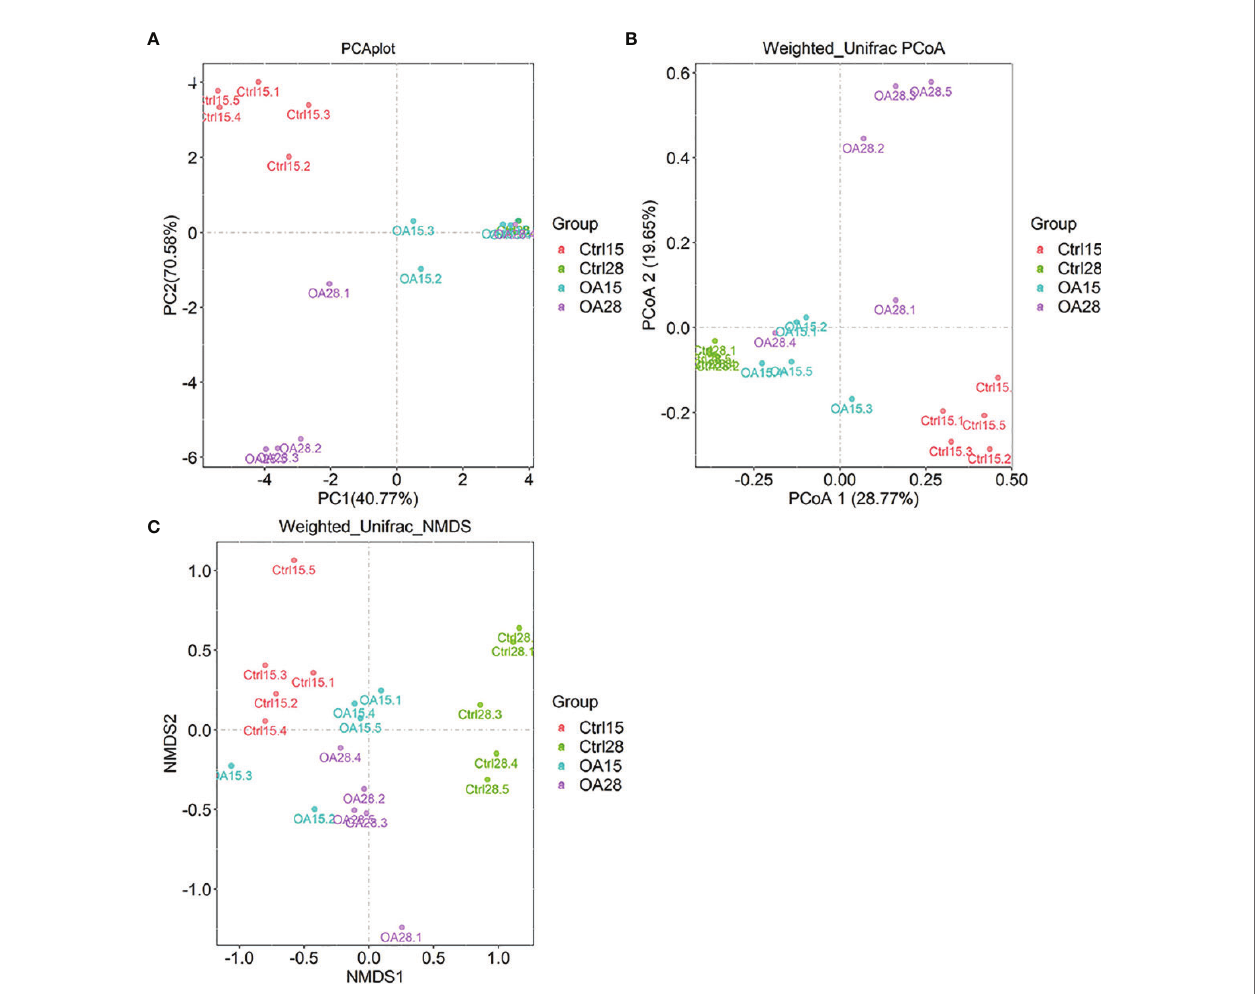
FIGURE 4 | The b -diversity in piglet intestinal fl ora. PCA plot (A) was based on OTU relative abundances, and samples are colored according to each sample group. PCoA plot (B) and NMDS plot (C) based on weighted UniFrac distances between samples calculated using OTU relative abundances. The variance explained by each axis is stated as a percentage in